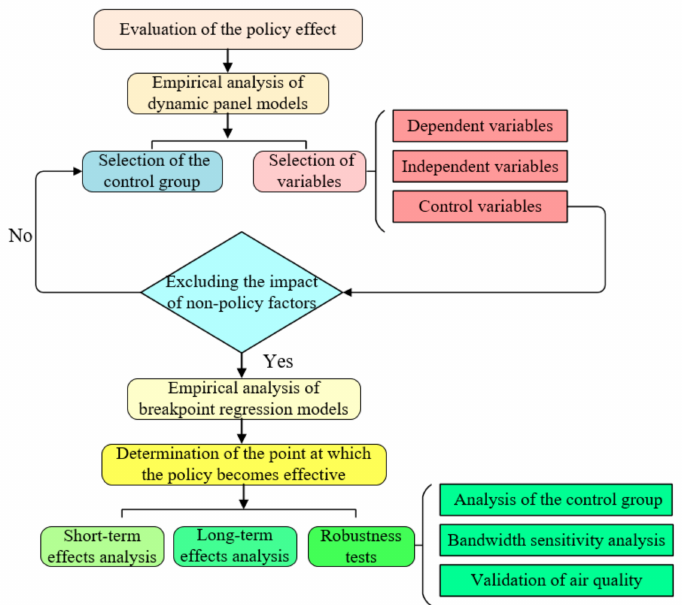
Figure 10. The process of evaluating the policy effectiveness of the environmental interview